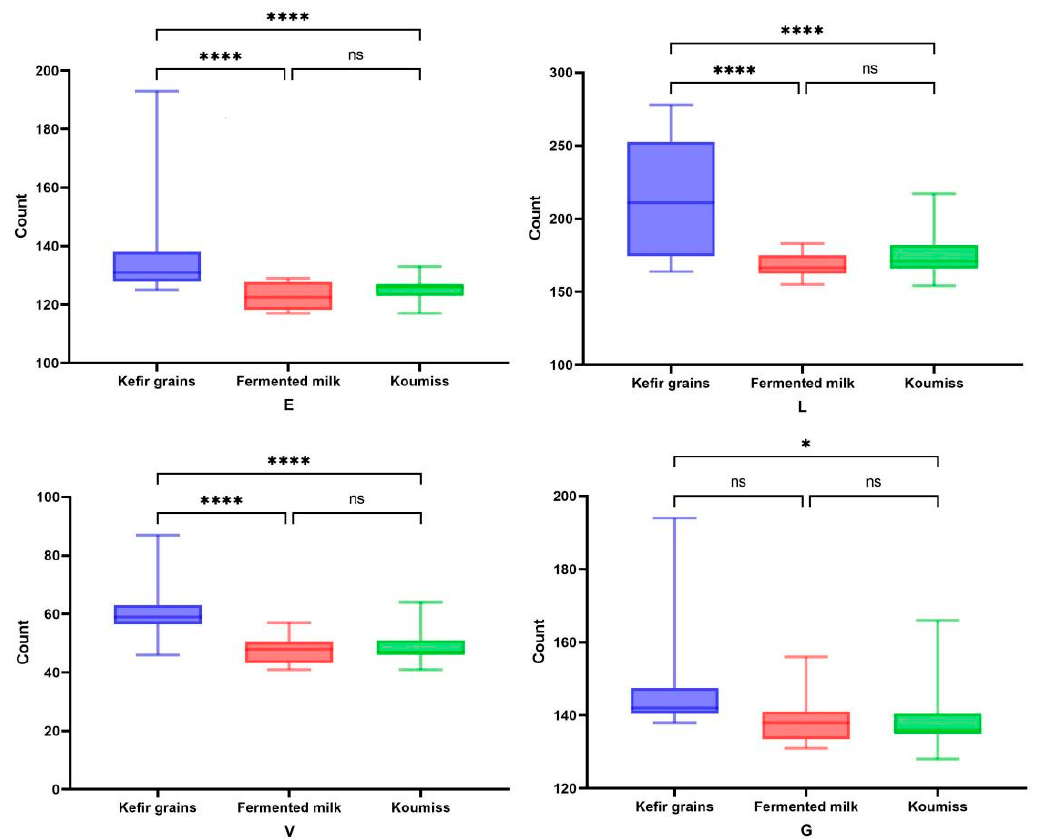
Figure 5. Differences in COG function annotation of different L. kefiranofaciens strains. *: Samples Figure 5. Di ff erences in COG function annotation of di ff erent L. ke fi ranofaciens strains. *: Samples have a little significant difference. ****: Samples have a large significant difference. ns: Samples have have a li tt le signi fi cant di ff erence. ****: Samples have a large signi fi cant di ff erence. ns: *: Samples no significant difference. E: Amino acid transport and metabolism. G: carbohydrate transport and have no signi fi cant di ff erence. E: Amino acid transport and metabolism. G: carbohydrate transport and metabolism. L: replication, recombination and repair. V: Defense mechanism. metabolism. L: replication, recombination and repair. V: Defense